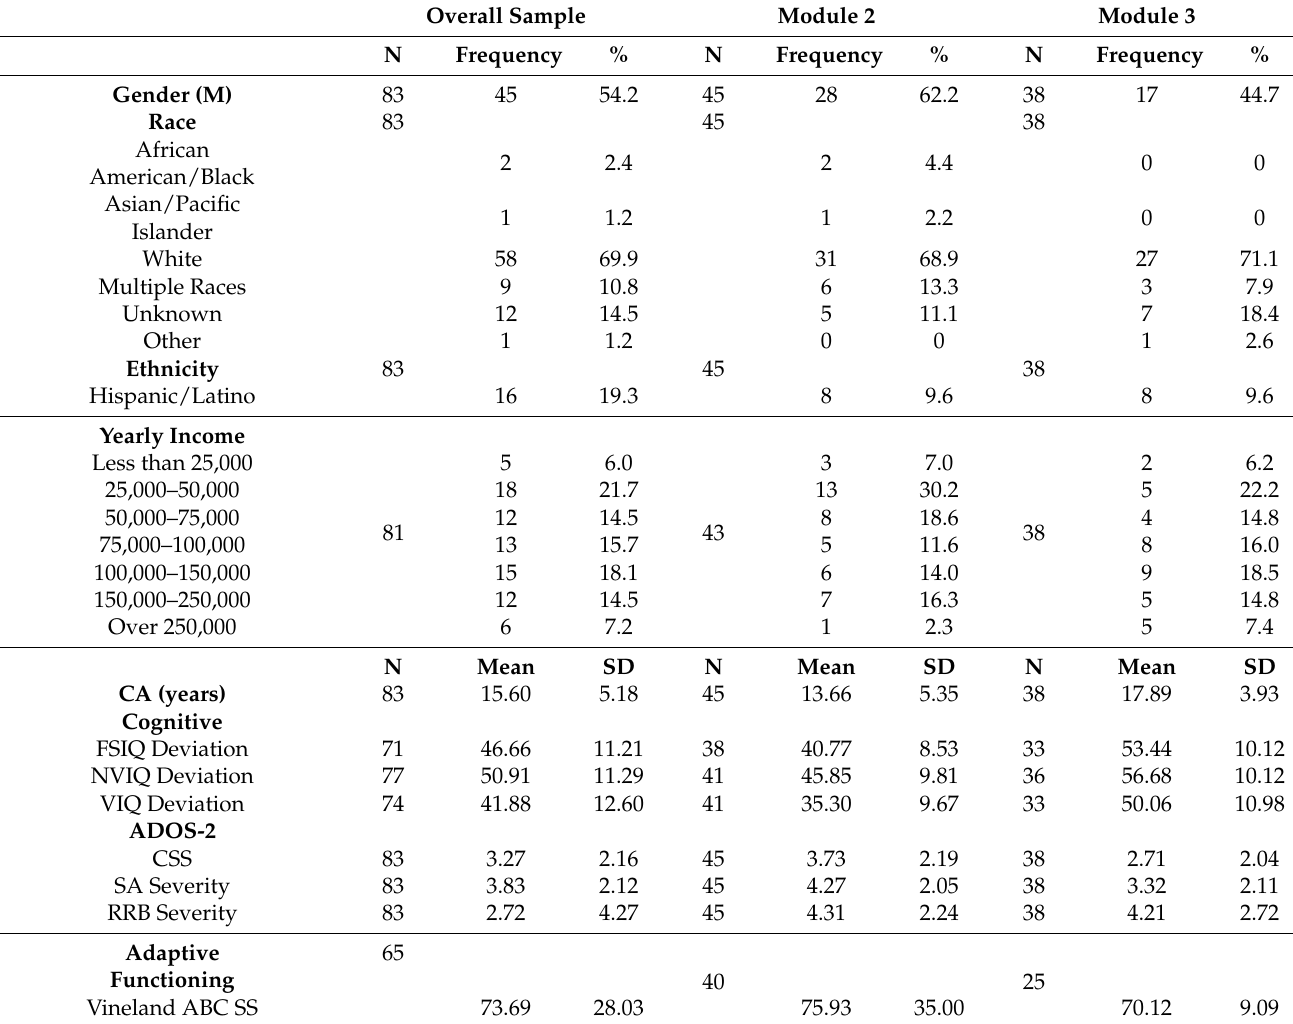
Table 1. Participant demographics for overall sample, Module 2 and Module